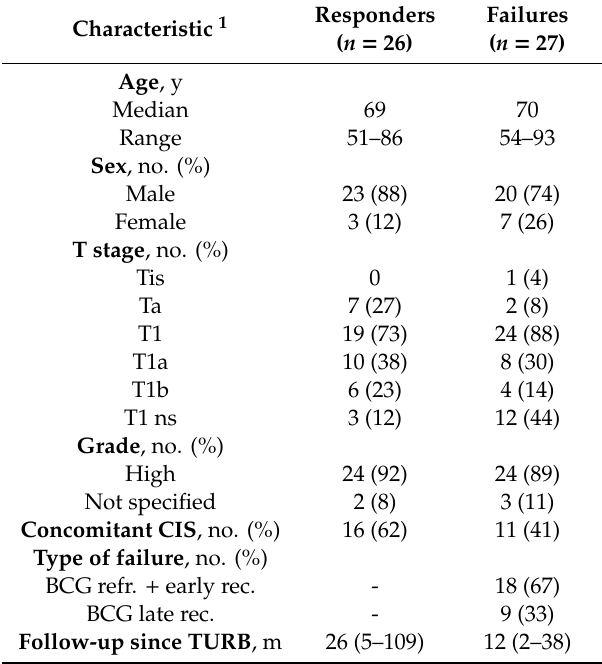
Table 1. Clinicopathological characteristics of Bacillus Calmette-Gu é rin (BCG) patients for Illumina array